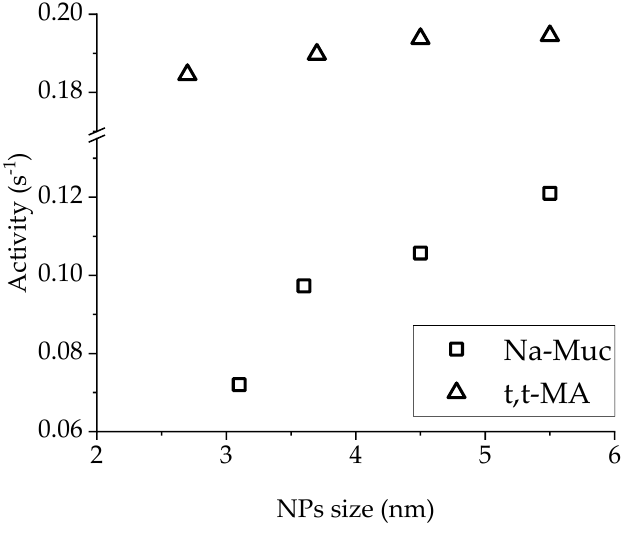
Figure 10. Activity (after 15 min) in function of Pd NPs size.